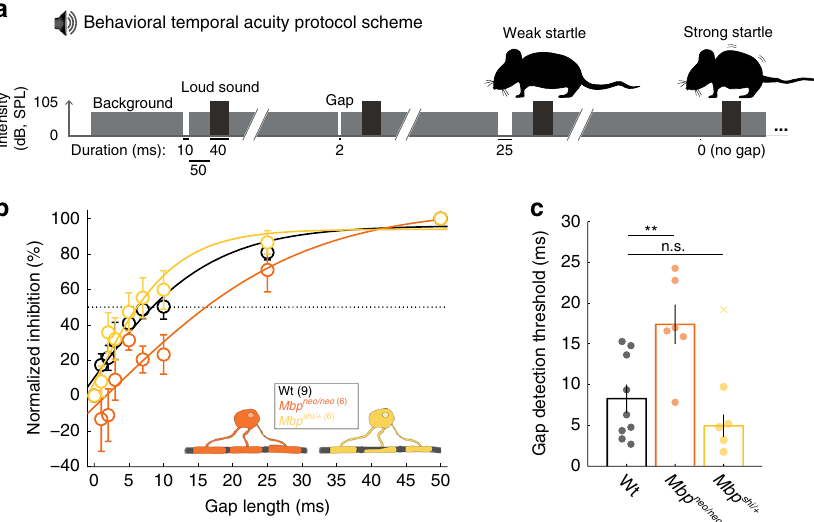
Fig. 4 Behavioral temporal acuity is impaired by central nervous system (CNS) dysmyelination. a Schematic of the auditory startle re fl ex (ASR) sound protocol. Constant background broadband noise (BBN, 70 dB) interrupted by a startle noise at random times (105 dB, 40 ms), occasionally preceded by a silent gap of varying length. All gaps presented were followed by 50-ms background sound before the startle appearance. The silent gap, if detected, diminished the startle effect of the loud noise. Each gap-startle combination was repeated ten times. b The percentage of ASR inhibition elicited by the different gaps showed a strong relationship between the gap length and the startle inhibition. Mbp neo/neo (orange, n = 6) but not Mbp shi/ + mice (with a 50% reduction in Mbp , yellow, n = 6) showed impaired inhibition of the ASR. Dotted line: threshold at 50% inhibition used for statistical analysis in c . c Gap-detection threshold is increased in Mbp neo/neo mice (two-sided Wilcoxon rank-sum test, P = 0.0048, t = 3.814), but not Mbp shi/ + (two-sided Wilcoxon rank-sum test, P = 0.36, t = − 2.485; outlier depicted with a cross), compared to Wt (black, n = 9) animals. All graphs depict the mean and S.E.M. and individual data points are individual animals. Outliers are depicted with an x and were not considered in the statistical analysis. Source data are provided as a Source Data fi